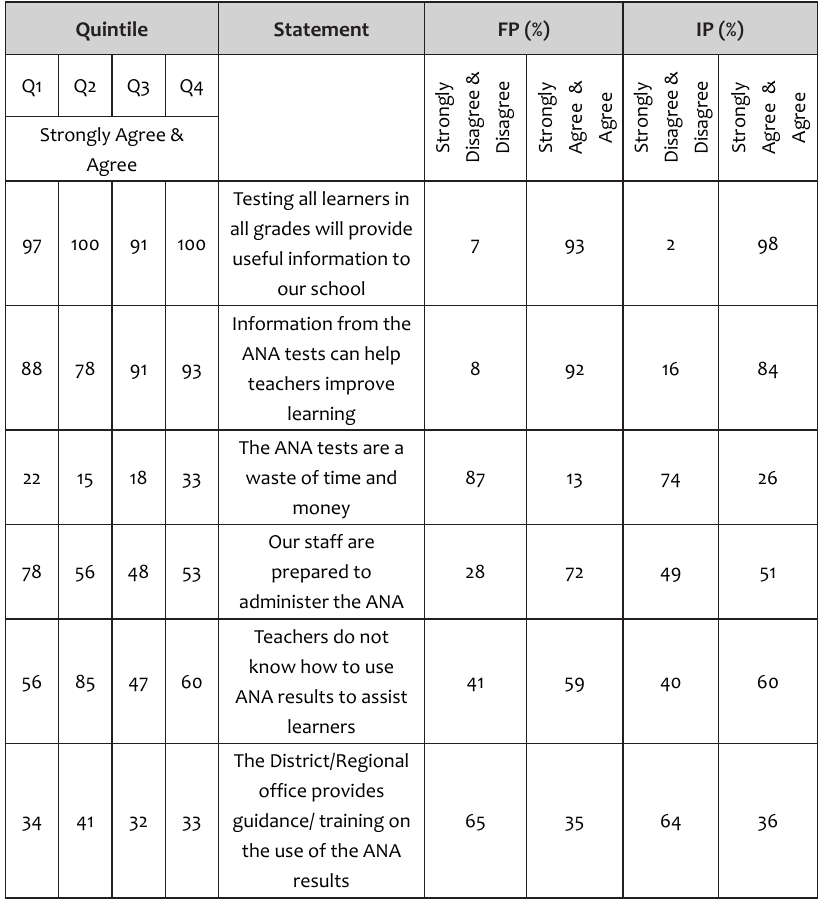
Table 1: Teacher views of ANAs by phase and quintile category